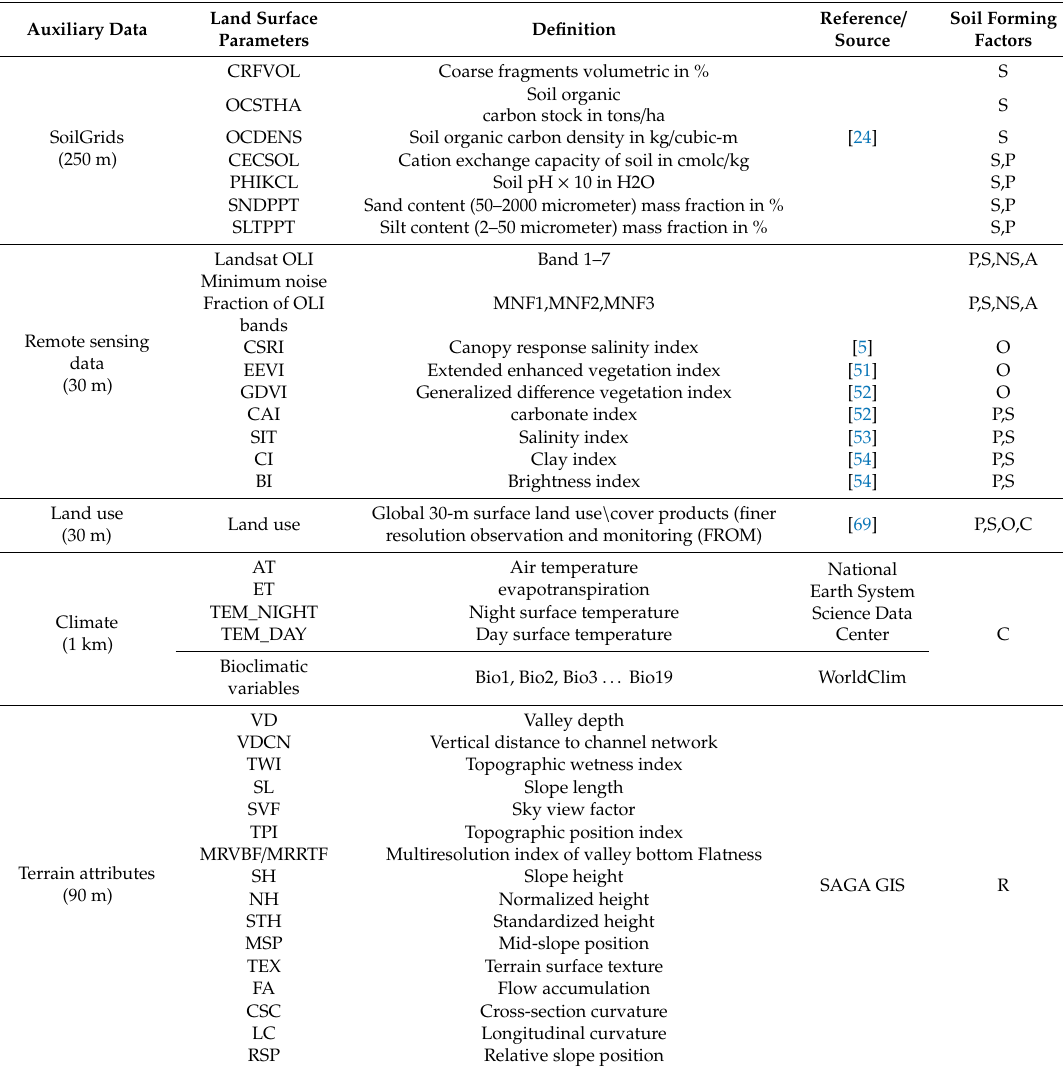
Table 1. Land surface parameters used for spatial prediction of